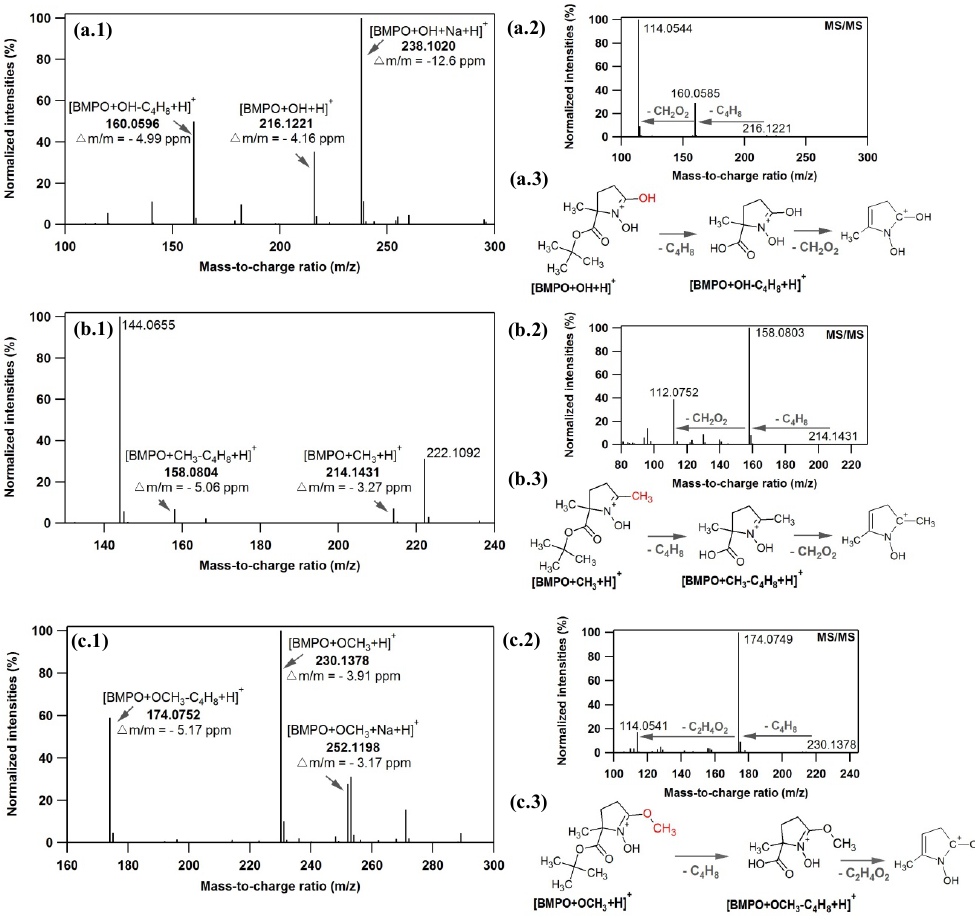
Figure A2. Mass spectra obtained with LC-MS/MS in the positive ionization mode from the mixture of tert-butyl hydroperox- ide, p-benzoquinone and BMPO in the presence of iron (solution 1). MS spectra of (a.1) BMPO + OH, (b.1) BMPO + CH 3